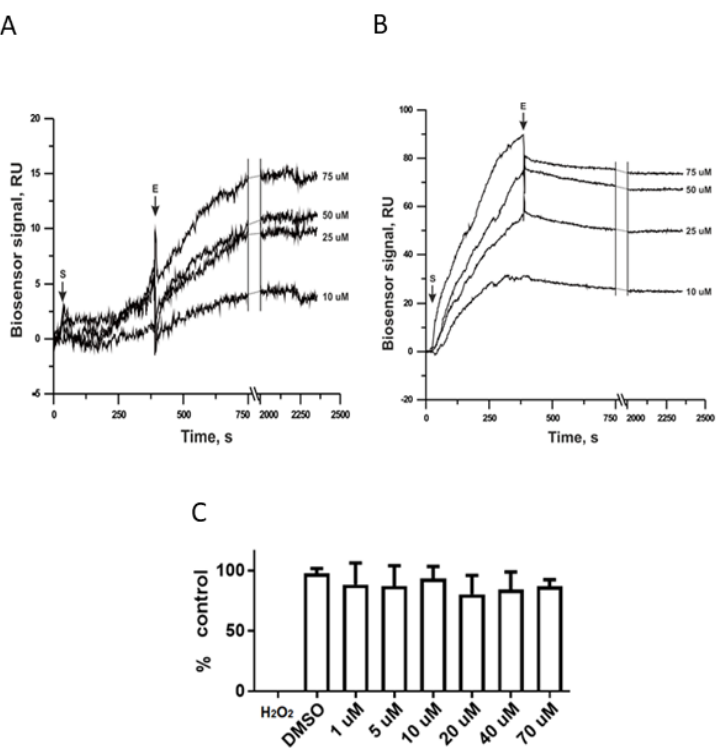
Figure 3. Sensograms of the surface plasmon resonance SPR assays and survival assays. ( A ) SPR from Candida ssp. and ( B ) SPR from Tc, both showing a correlation between sensor signal and time per second at a range of a ffi nity concentration subsets (10 µ M, 25 µ M, 50 µ M and 75 µ M). The data are representative of the results of three independent experiments. Both ( A , B ) show association and disassociation e ff ect E of interaction in the arrow at the top; ( C ) as negative control results of a C. albicans survival test in the presence of ergosterol peroxide through a concentration gradient, taken from the average of three time windows (18, 24 and 48 h). Each bar represents the results of three independent experiments. Biomolecules 2019 , 9 , x FOR PEER REVIEW